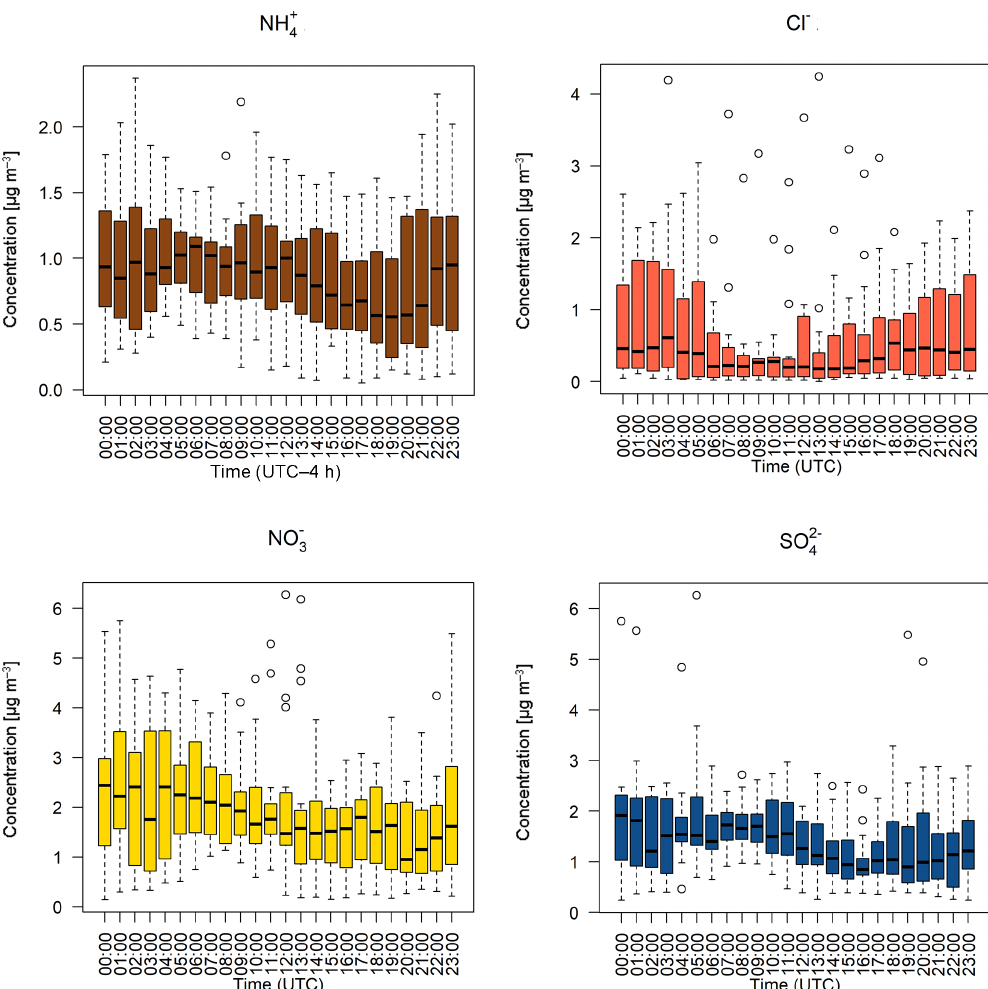
Figure 6. Hourly median diel water-soluble aerosol concentrations measured by the GRAEGOR at 2.4m. Boxes show the lower and upper quartiles and whiskers the 5% to 95% range, with outliers shown as